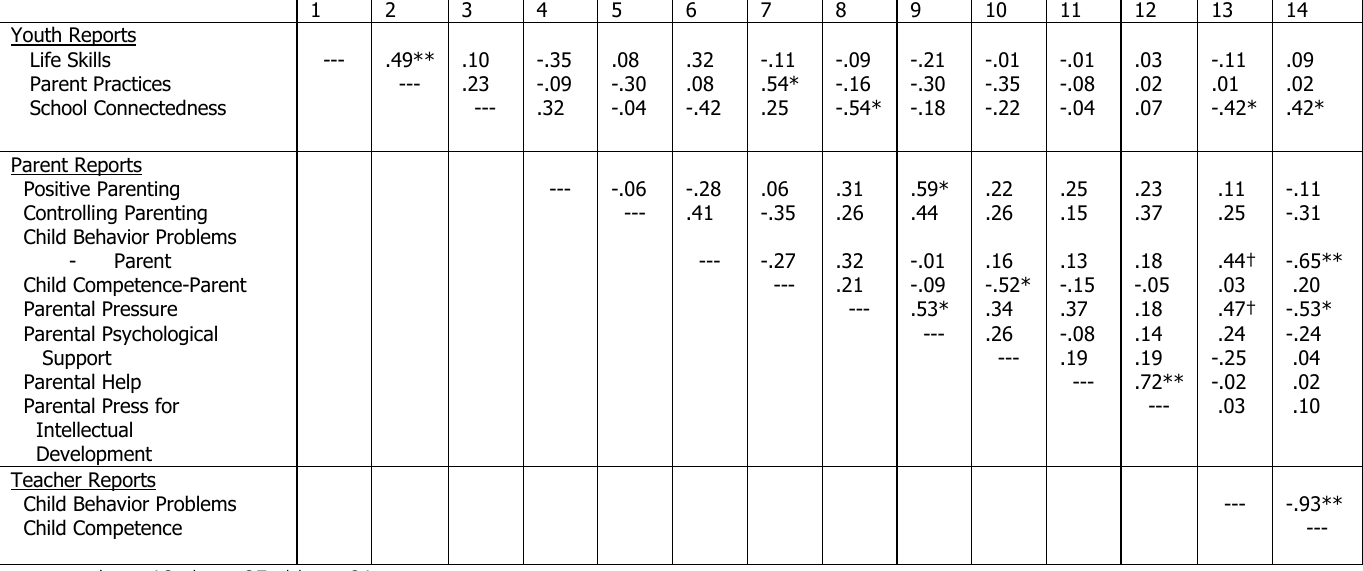
Correlation Coefficients of Study Variables: Teacher, Youth, and Parent